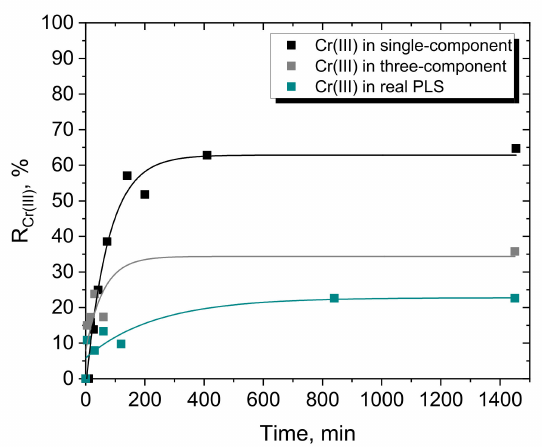
Figure 8. Removal of Cr(III) in the fixed-bed column with Dowex G26 resin from ( ) single-component model solution (1 g/dm 3 Cr(III), 3 M H + ), ( ) three-component model solution (1 g/dm 3 Cr(III), 1 g/dm 3 Ni(II), 1 g/dm 3 Co(II), 3 M H + ), ( ) real PLS after DD (24.5 g/dm 3 Cr(III), 37.2 g/dm 3 Ni(II), 21.4 g/dm 3 Co(II), 3.46 M H + ) (flow rate 4.4 cm 3 /min).